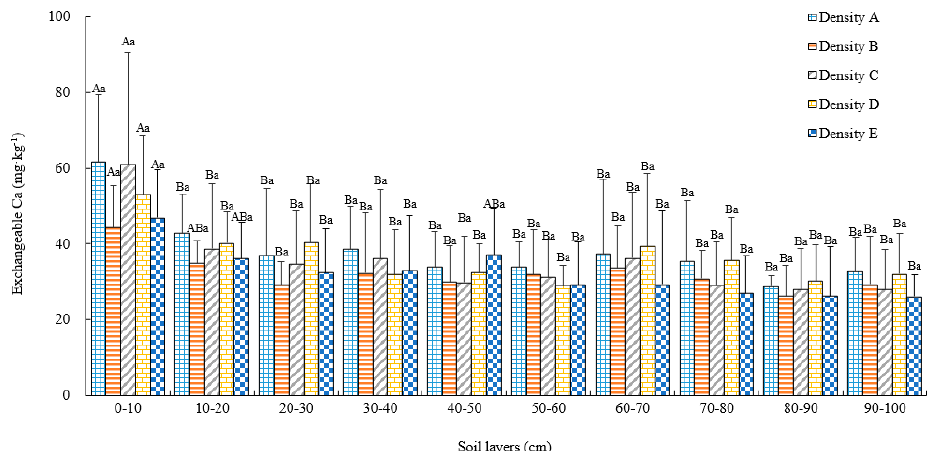
Figure 9. Soil exchangeable Ca in different layers under different stand densities (mg·kg − 1 ). Note: different lowercase letters indicate significant differences among different densities at the 0.05 level, and different capital letters of the same density indicate significant differences among different soil layers at the 0.05 level.